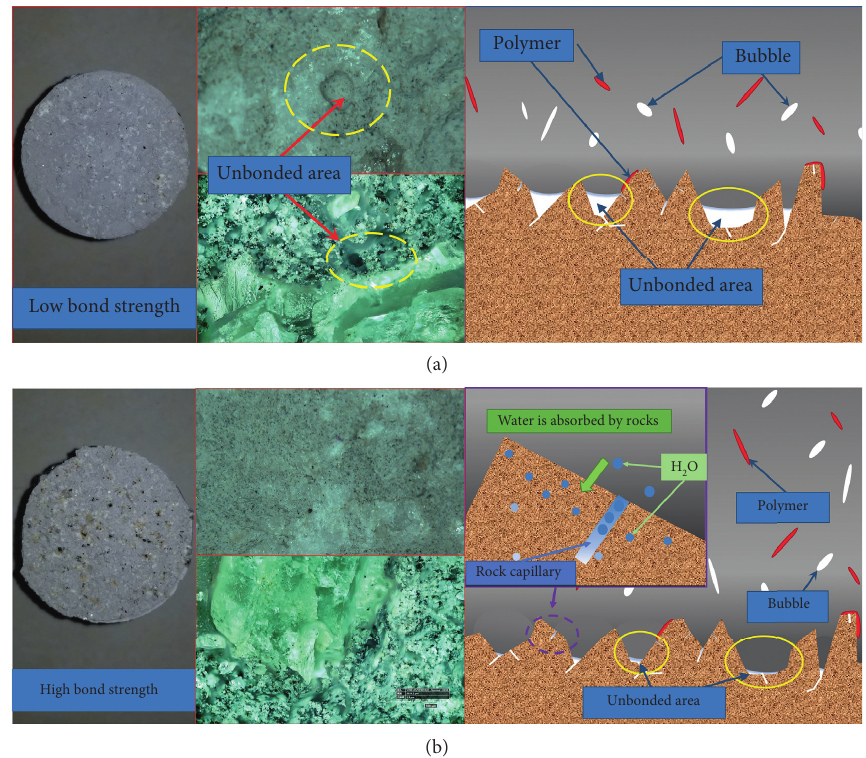
Figure 12: Schematic diagram of bonding of different fluid materials: (a) low-flow material and (b) high-flow